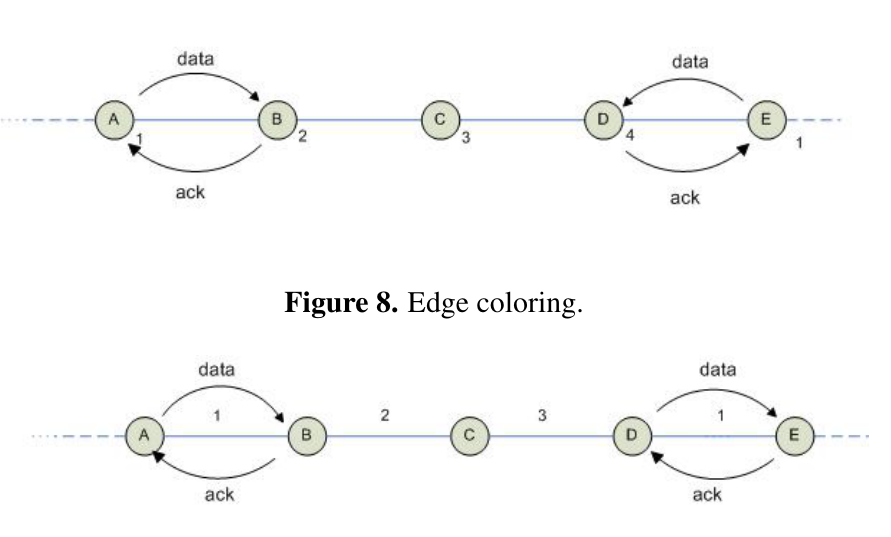
Figure 7. Vertex coloring.